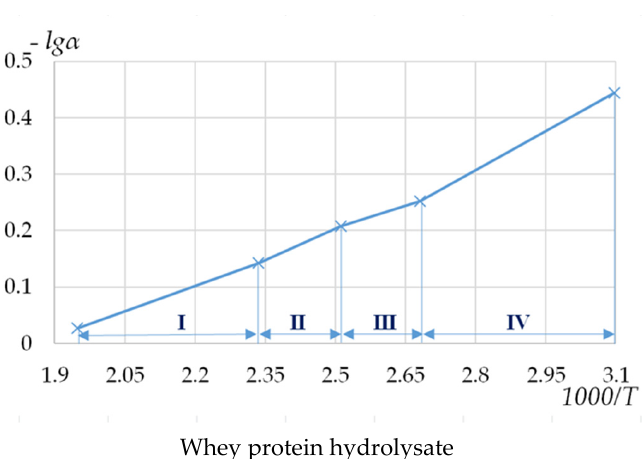
Figure 3. Dependence of ( − lg α ) on the value 1000/T during heating the studied samples.